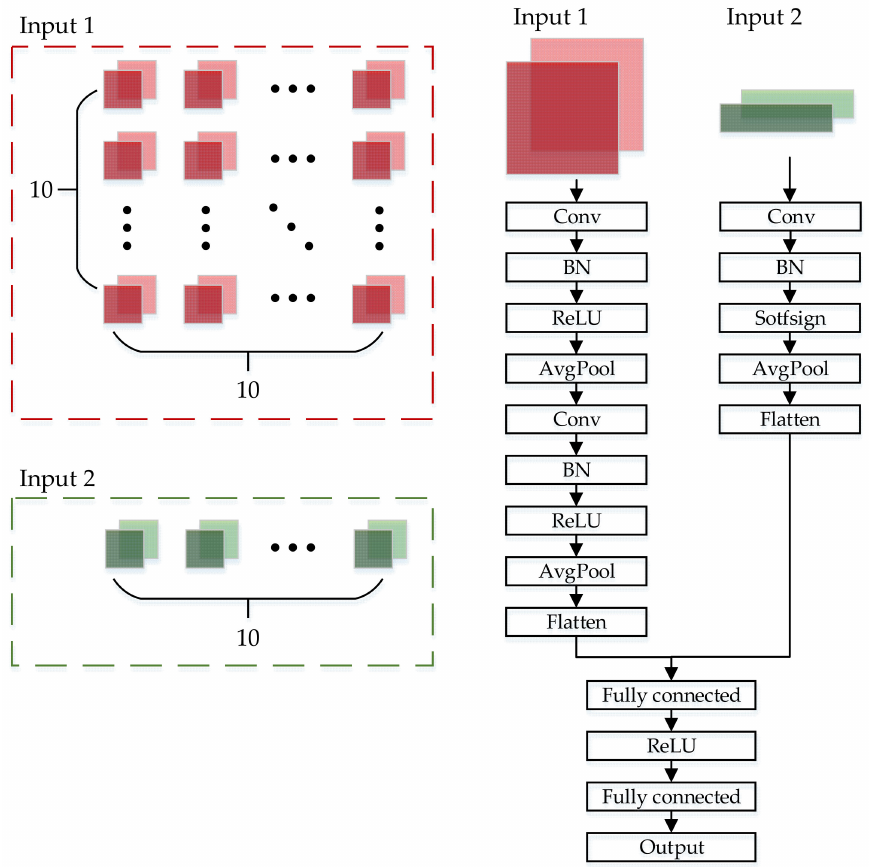
Figure 4. The architecture of